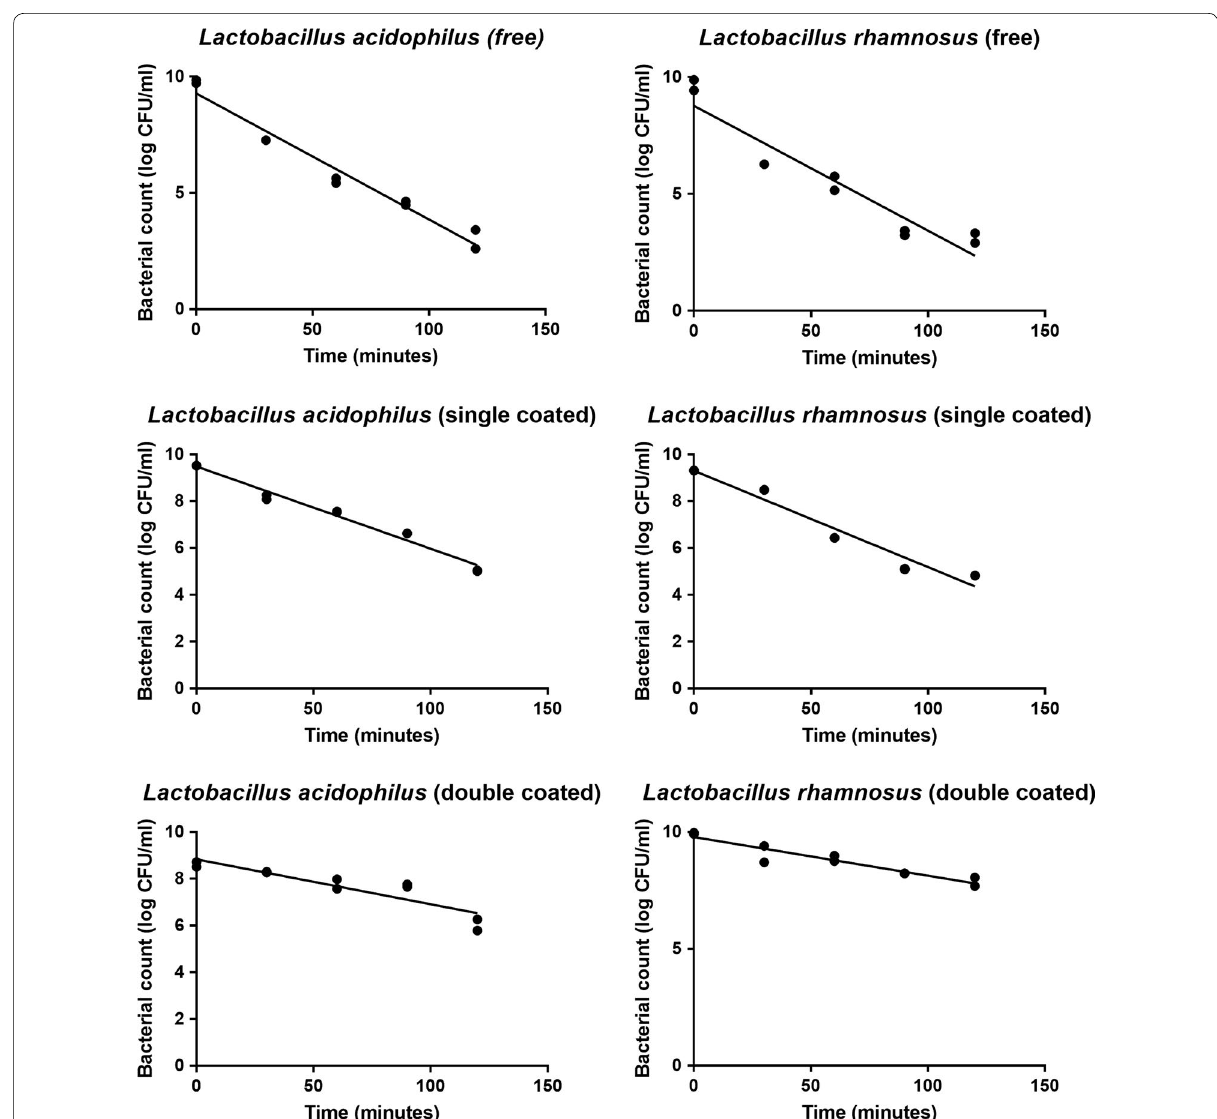
Fig. 5 Cell survivability (log CFU ml − 1 ) of three forms of Lactobacillus acidophilus and Lactobacillus rhamnosus (free, mono layer and double layer) after treatment in simulated gastric juice during 120 min (with 30 min interval) and then treatment in simulated intestinal juice with bile salt for 150 min ( Circles represent bacterial count in each sample and the line is demonstrating the linear estimation of bacterial